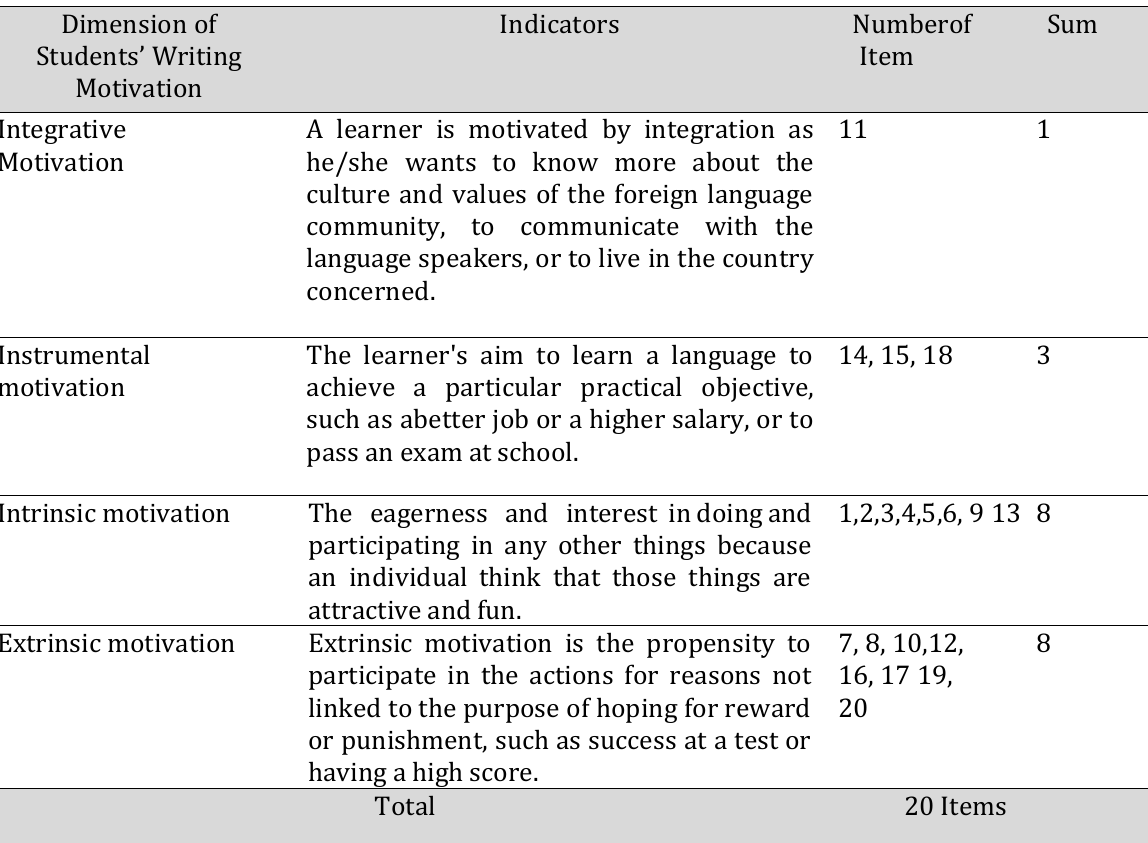
Table 2. The questionnaire grille of the students’ writing